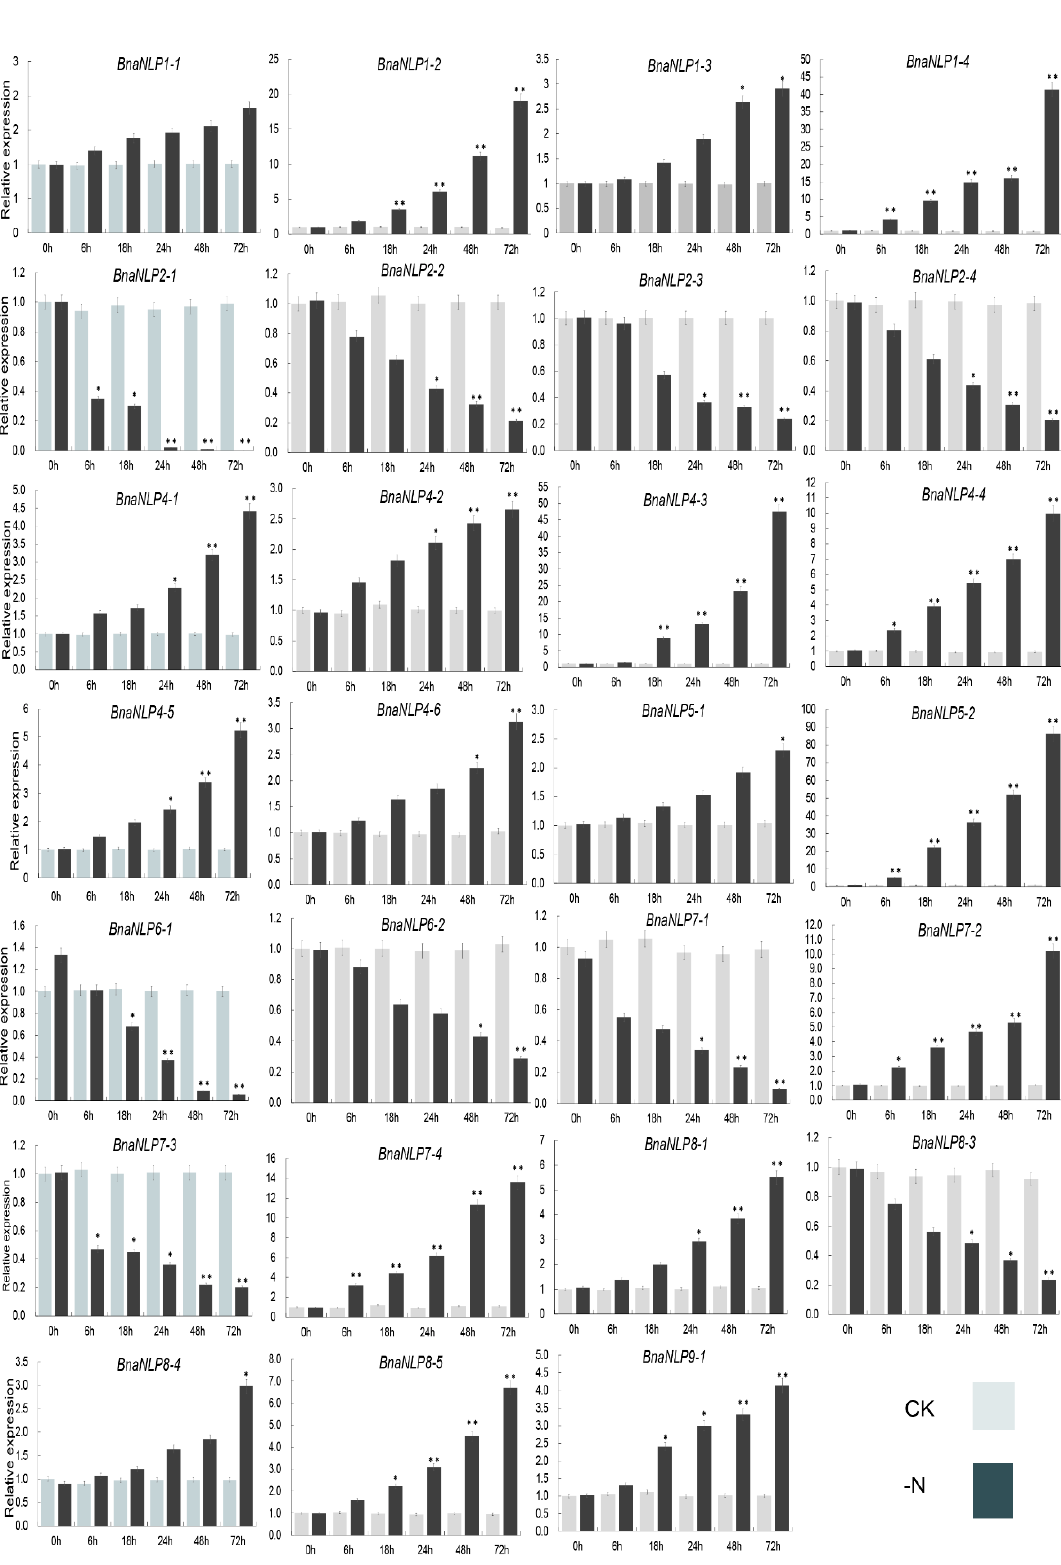
Figure 8. Expression profiles of BnaNLP genes in SLs under normal and nitrogen deficient conditions. Relative expression levels of BnaNLP genes were determined by RT-qPCR. SRs were collected under normal growth and nitrogen deficient conditions at 0, 6, 12, 24, 48 and 72 h after treatments. * represents the significant level, ** represents the extremely significant level.